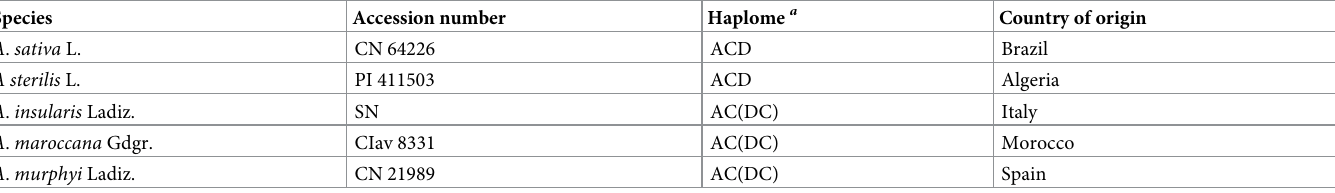
Table 1. List of materials used in this study, including species name, accession number, haplome and origin. Species